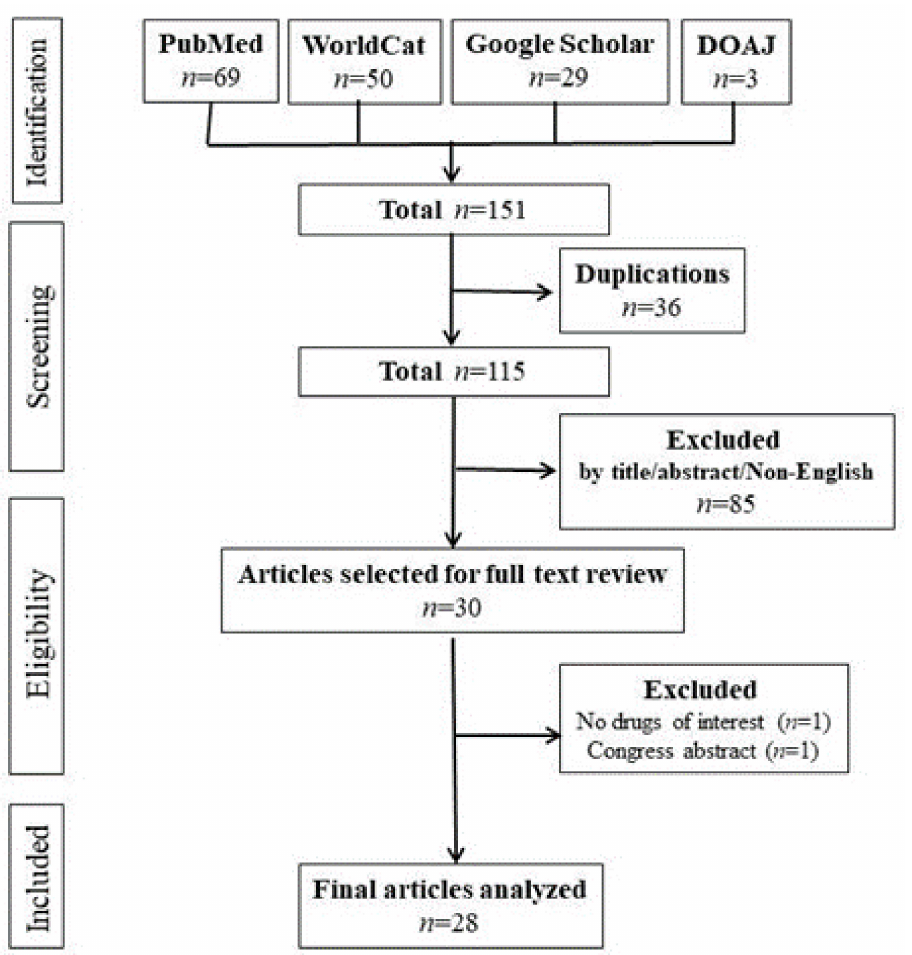
Figure 1. Literature search flow. Legend: A total of 151 abstracts were found from four databases of Pubmed, WorldCat, Google Scholar, and DOAJ. Twenty-eight articles met the inclusion